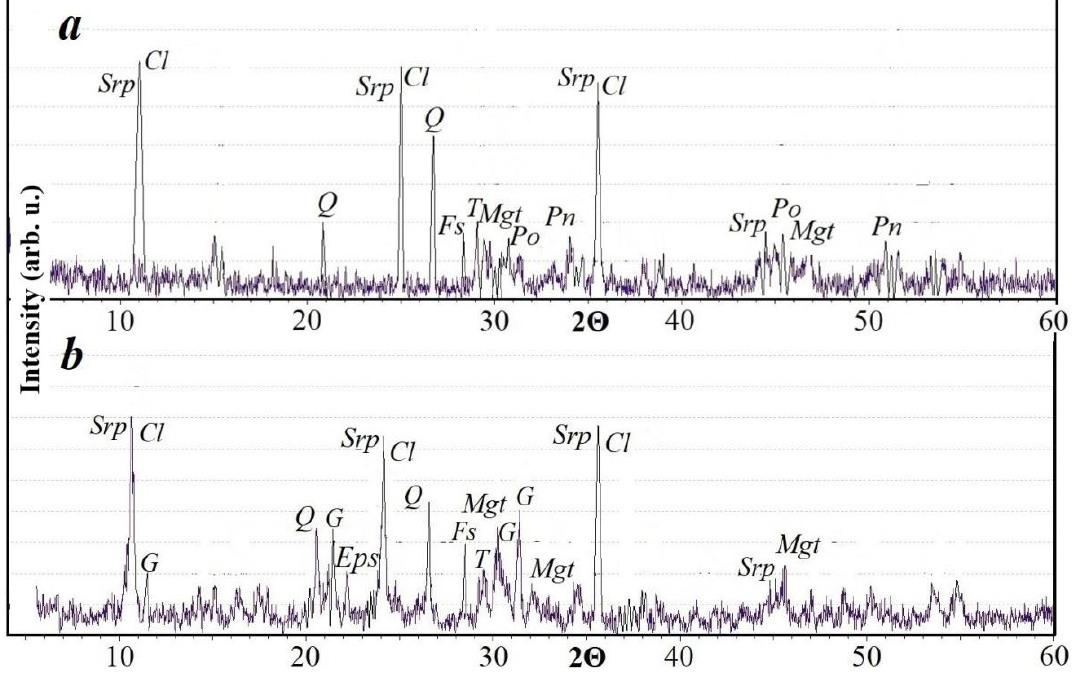
Figure 3. XRD pattern of an original sample of the copper-nickel tailings ( a ) and same tailings after leaching for 40 days ( b ). Reflexes: Srp — serpentine, Cl — chlorite, Q — quartz, G — gypsum, Mgt — magnetite, Fs — feldspar, T — talc, Po — pyrrhotite, Pn — pentlandite, Eps — epsomite.